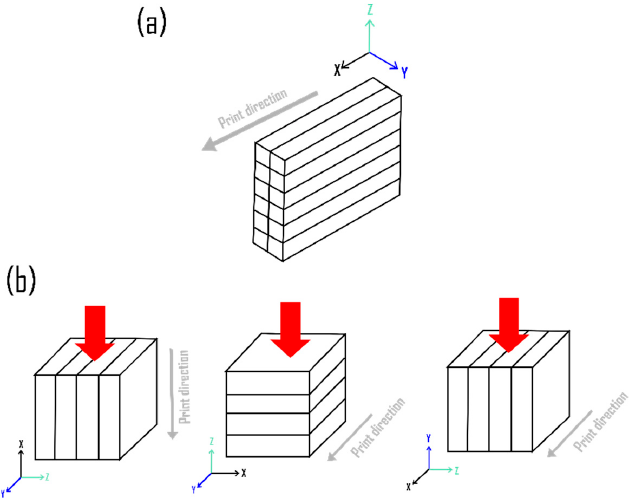
Figure 4. Illustration of ( a ) 3D printed beam and ( b ) the direction of loading (red arrow) on the extracted cubes during the compression test.